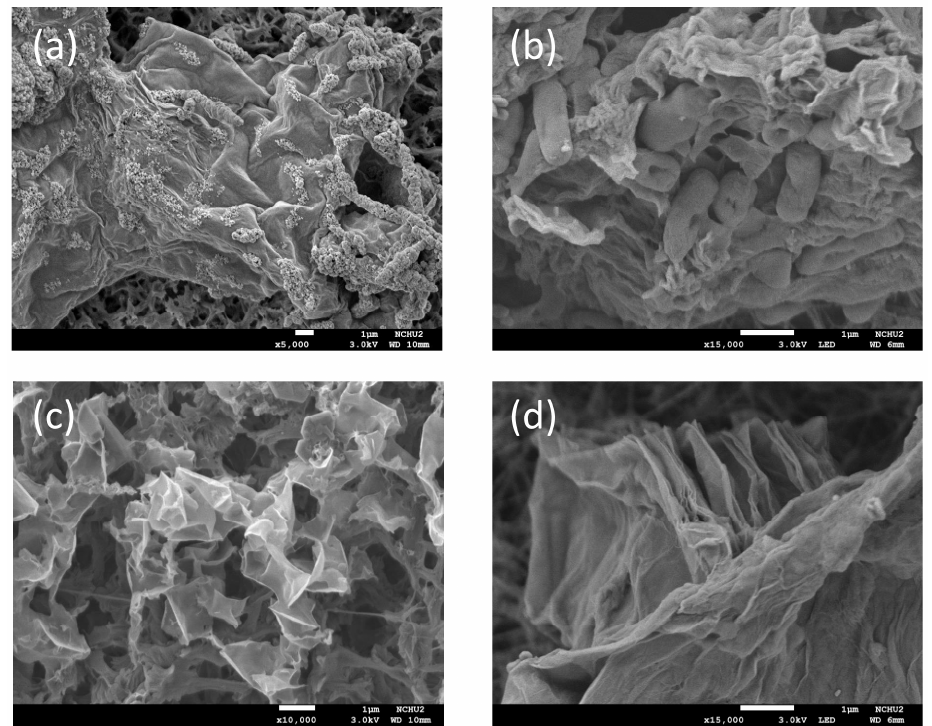
Figure 2. SEM images of ( a ) GO, ( b ) S. decolorationis cells with rGO, ( c ) rGO after S. decolorationis NTOU1 cells removal, and ( d ) rGO material consisting of individual sheets. It was confirmed that after GO was reduced to rGO by microorganisms, the surface structure changed from flat and smooth to corrugated and wrinkled.